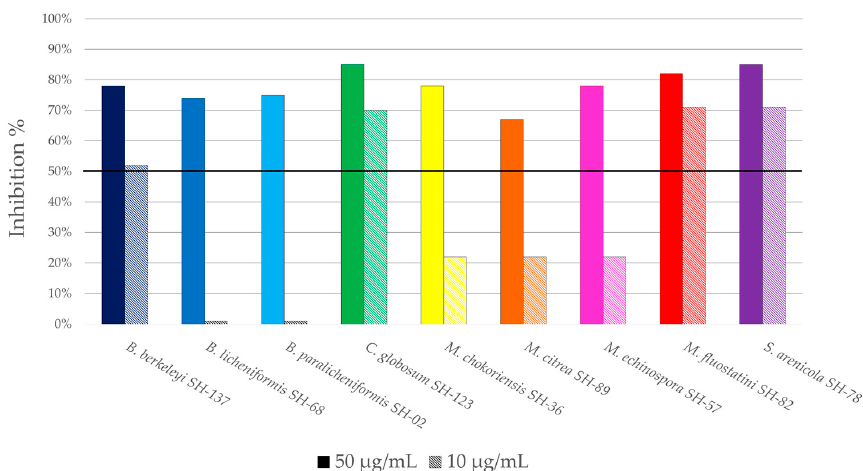
Figure 6. Antiplasmodial activities of crude microbial extracts against P. falciparum 3D7 strain, showing the ratio of inhibition at two concentrations. The different colors correspond to the different microbial strains. Horizontal black line indicates the threshold for promising strains (inhibition > 50%).